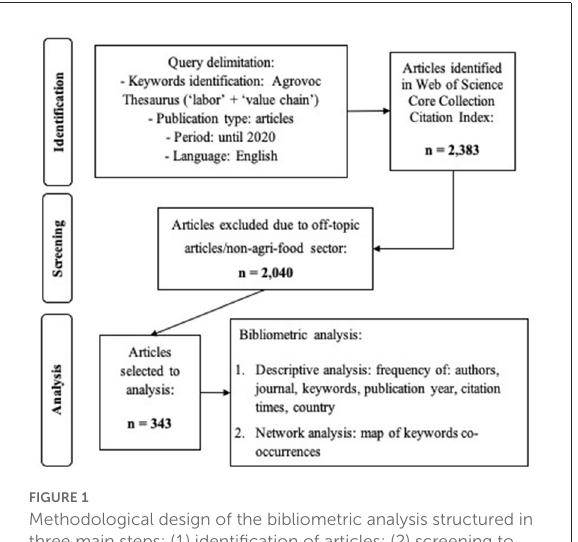
FIGURE1 Methodological design of the bibliometric analysis structured in three main steps: (1) identification of articles; (2) screening to exclude off-topic articles; (3) final selection of articles and analysis. Adapted from Moher et al.